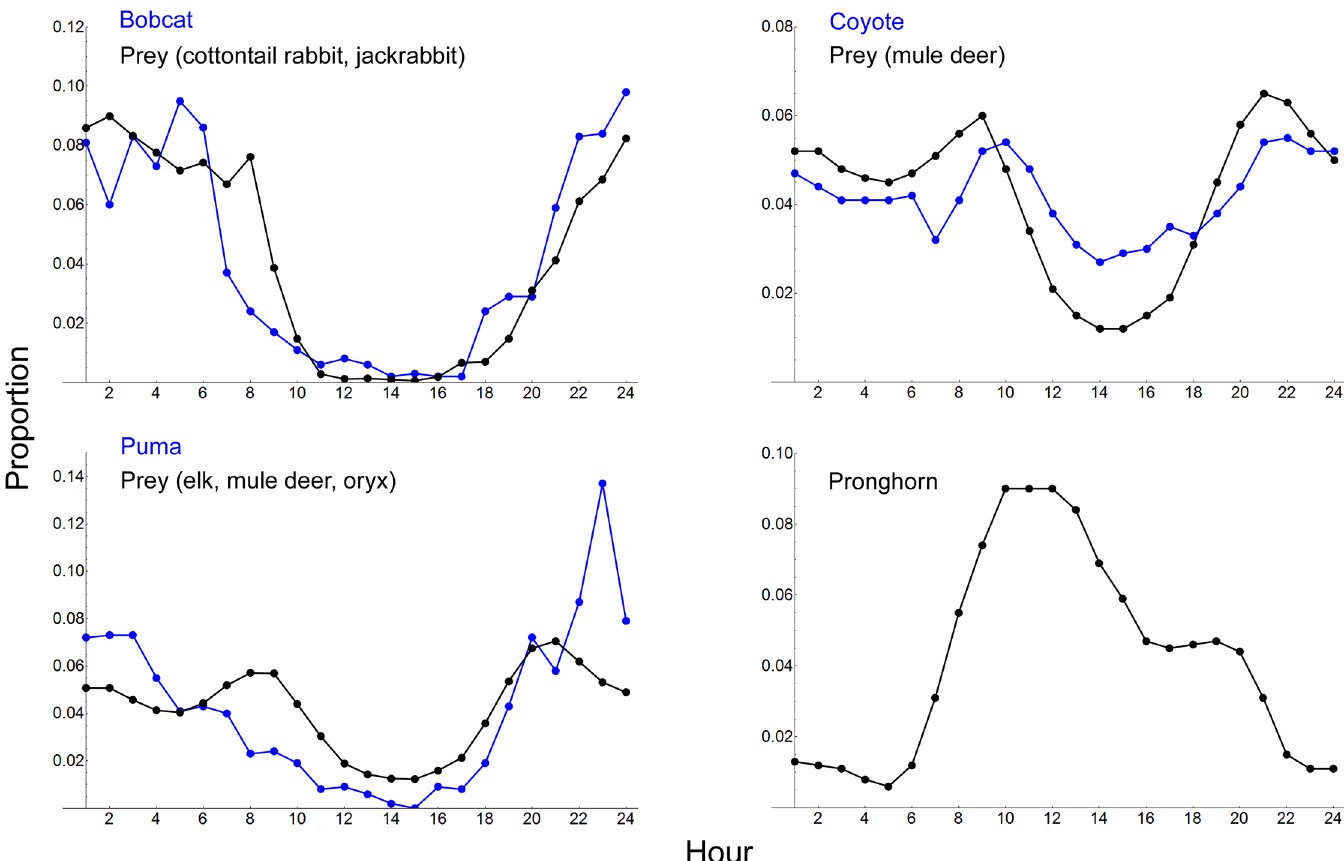
Fig 4. Activity Patterns. Daily activity patterns (based on species presence/absence at an hourly resolution) for mammalian predators (blue) and prey (black) at Sevilleta National Wildlife Refuge, New Mexico, USA, from June 29, 2009 – September 15, 2014. Prey was identified based on the models receiving most support, which predicted visitation to water for each predator. None of the predator models included pronghorn as a predictor for water visitation. The vertical axis represents the proportion of visitation.